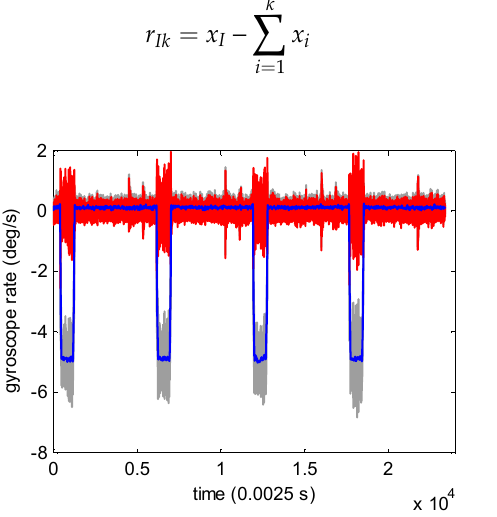
Figure 1. Signal decomposition results (grey: original gyroscope signal; blue: adaptive chirp mode pursuit (ACMP) result; red: residue).